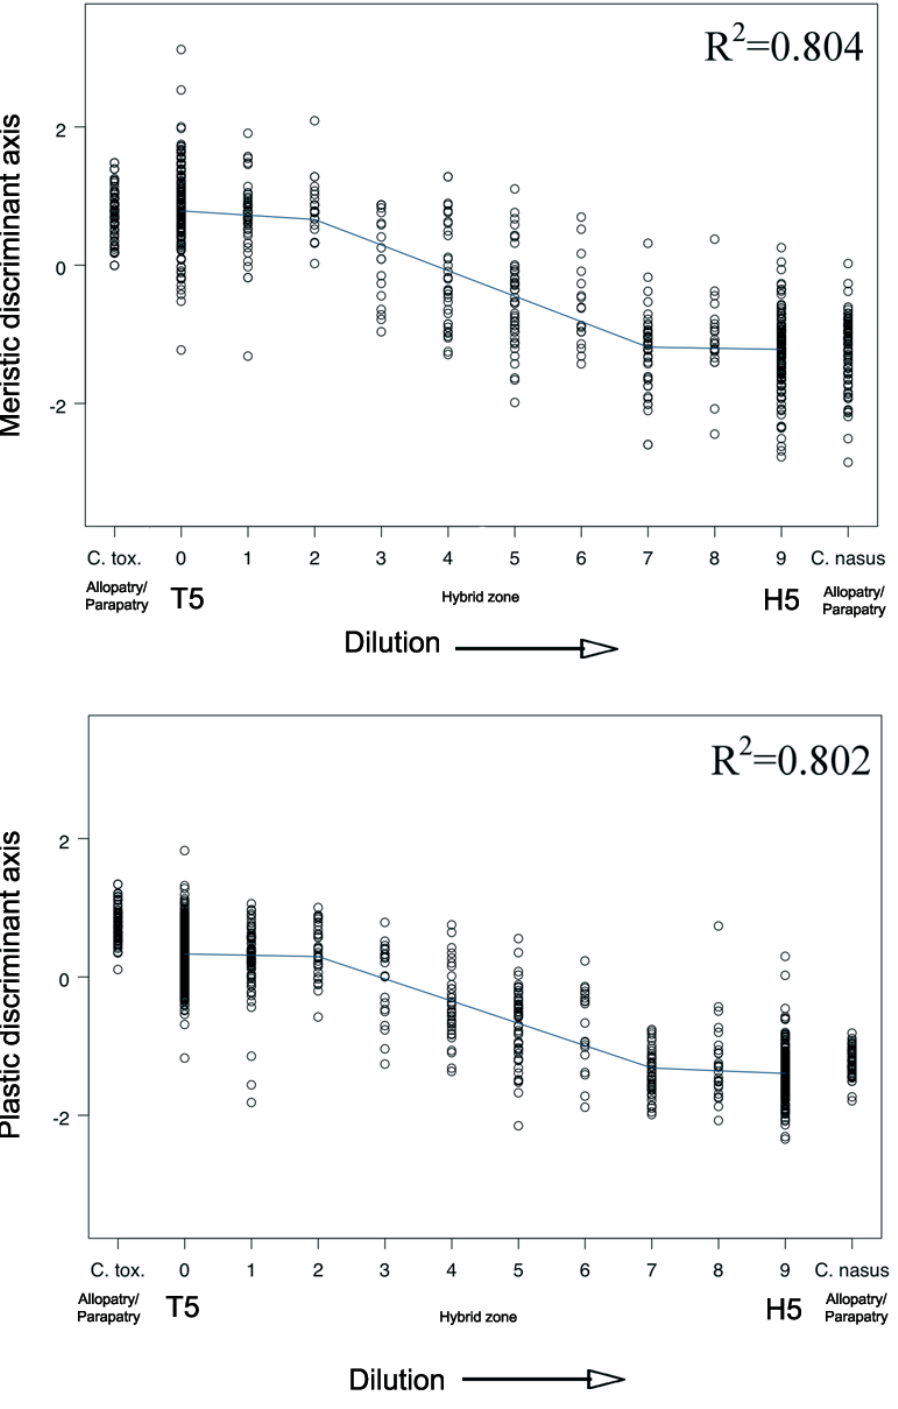
Figure 3. CORRELATION BETWEEN MORPHOLOGY AND GENE DILUTION. Correlation between morphology (meristic at the top and plastic at the bottom) and the degree of introgression (percentage of genes belonging to each of the two species) or